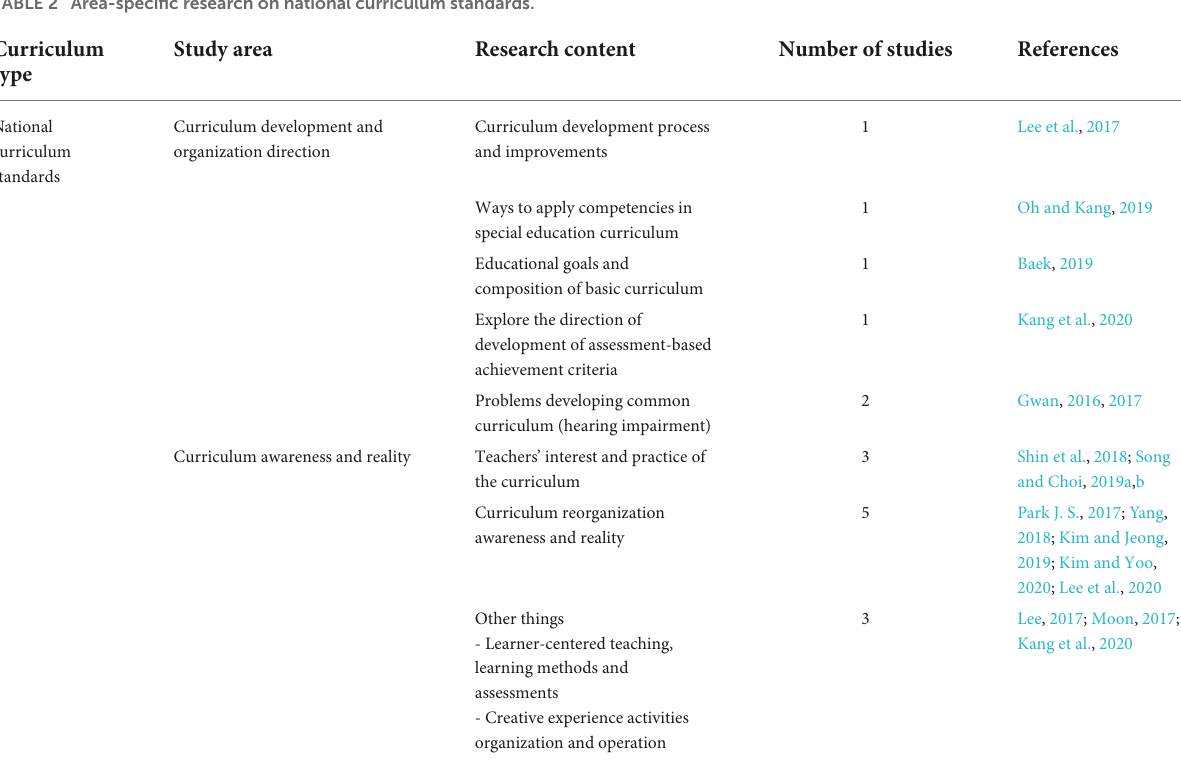
TABLE 2 Area-specific research on national curriculum